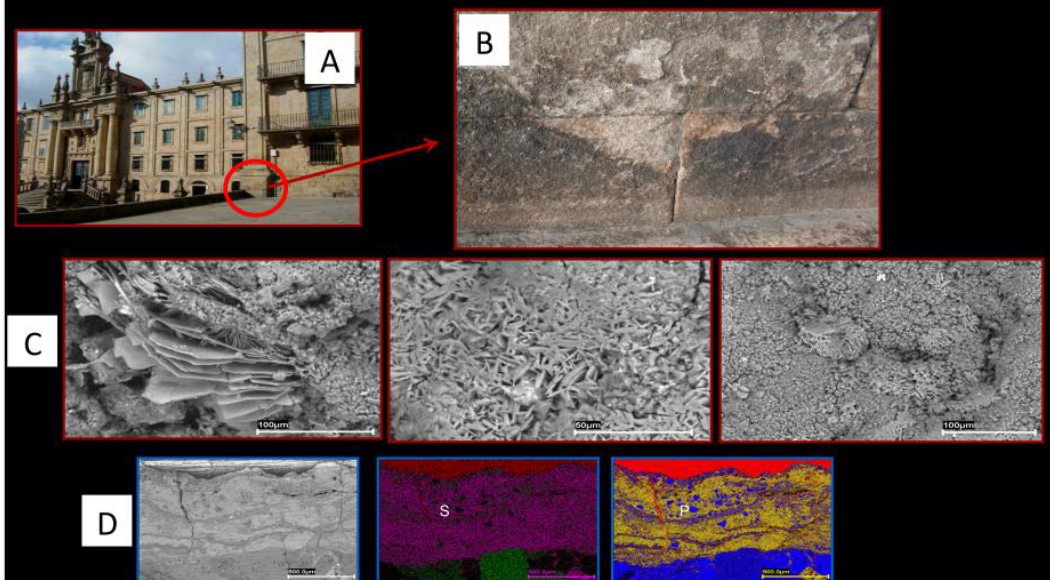
Figure 2. Covering layer on Monastery of San Martiño Pinario (Santiago de Compostela). ( A ) Area of the wall on the main entrance where the covering layer was taken, ( B ) detail of the sampled area, ( C ) SEM pictures of the covering layer, and ( D ) SEM picture (left) and EDS pictures (middle and right) of the cross-section of the